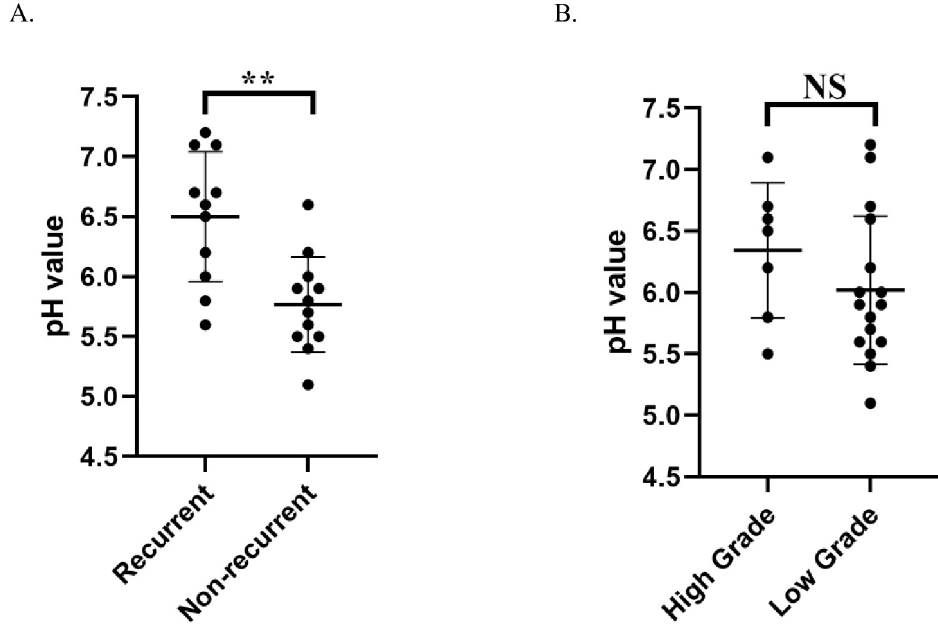
Fig 4. The pH value of urine between (A) recurrent and non-recurrent group, and (B) high-grade and low-grade tumor group.